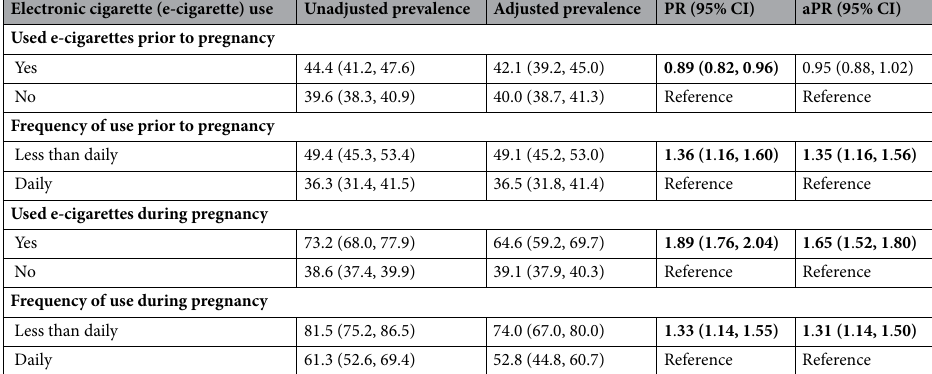
Patterns in combustible and e-cigarette use. Among the 16,022 women who self-reported smok- ing combustible cigarettes during the three months prior to becoming pregnant, 14.8% (95% CI 13.9, 15.7%) reported also using e-cigarettes prior to pregnancy (Fig. 1). Of these women, 44.4% (95% CI 41.2, 47.6%) con- tinued to smoke combustible cigarettes and 55.6% (95% CI 52.4, 58.8%) quit combustible cigarettes during pregnancy. Nearly half (42.8%; 95% CI 38.1, 47.6%) of e-cigarette users who continued smoking combustible cigarettes during pregnancy also continued e-cigarette use during pregnancy. Among the 85.2% (95% CI 84.3, 86.1%) of combustible cigarette smokers who did not use e-cigarettes prior to pregnancy, 60.4% (95% CI 59.1, 61.7%) quit smoking during pregnancy. Few women who quit combustible cigarette use during pregnancy and did not use e-cigarettes prior to pregnancy initiated e-cigarette use during pregnancy (0.6%; 95% CI 0.4, 0.8%). The prevalence of pregnant women with a history of combustible cigarette smoking and who used e-cigarettes during pregnancy ranged from 3.7% (95% CI 3.9, 5.6%) in 2016 to 4.9% (95% CI 3.0, 6.1%) in 2018. Overall, we observed no difference in the prevalence of combustible cigarette smoking among women who used e-cigarettes prior to pregnancy compared to women who did not (aPR 0.95; 95% CI 0.88, 1.02) (Table 1). However, women who used e-cigarettes less than daily during the three months prior to pregnancy had a higher prevalence of combustible cigarette smoking during pregnancy compared to women who used e-cigarettes daily (aPR 1.35; 95% CI 1.16, 1.56). The prevalence of combustible cigarette smoking was higher among women who used e-cigarettes during pregnancy compared to non-users (aPR 1.65; 95% CI 1.52, 1.80), and women who used e-cigarettes less than daily during the last three months of pregnancy had a higher prevalence of combustible cigarette smoking compared to women who used e-cigarettes daily (aPR 1.31; 95% CI 1.14, 1.50). We found no difference in the number of cigarettes smoked for women used e-cigarettes during ( P = 0.15) as compared to smokers who did not use e-cigarettes (Supplemental Figure S3). Based on this information, we classed 8938 women as former smokers (58.5%; 95% CI 57.3, 59.7%), 189 as e-cigarette only users (1.3%; 95% CI 1.0, 1.6%), 585 as dual users (3.4%; 95% CI 3.0, 3.9%), and 6310 as current smokers (36.8%; 95% CI 35.7, 38.0%) (Table 2). Compared to former smokers, a higher percentage of respondents who used e-cigarettes during pregnancy were 18–24 years of age, non-Hispanic white, had less than or equal to